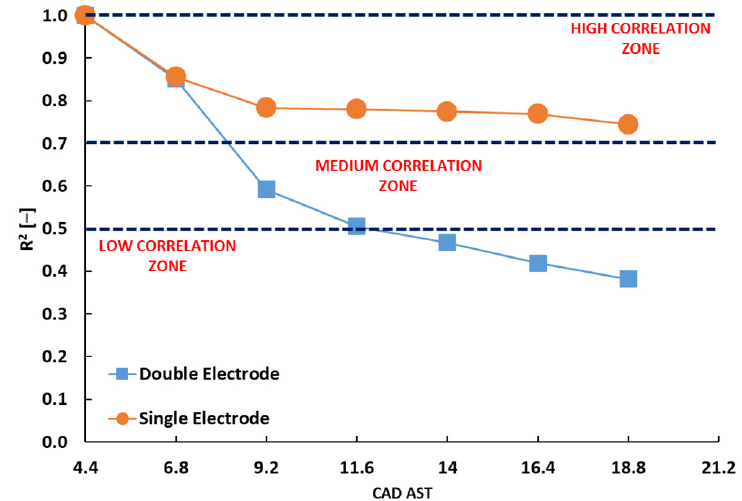
Figure 10. Evolution of the coefficient of determination R 2 of the linear fit between kernel position and flame displacement at CA5 during the early stages of combustion during the early stages of the combustion process for the cross-flow orientation at fixed SA (16 CAD) and AFR rel (1.15).